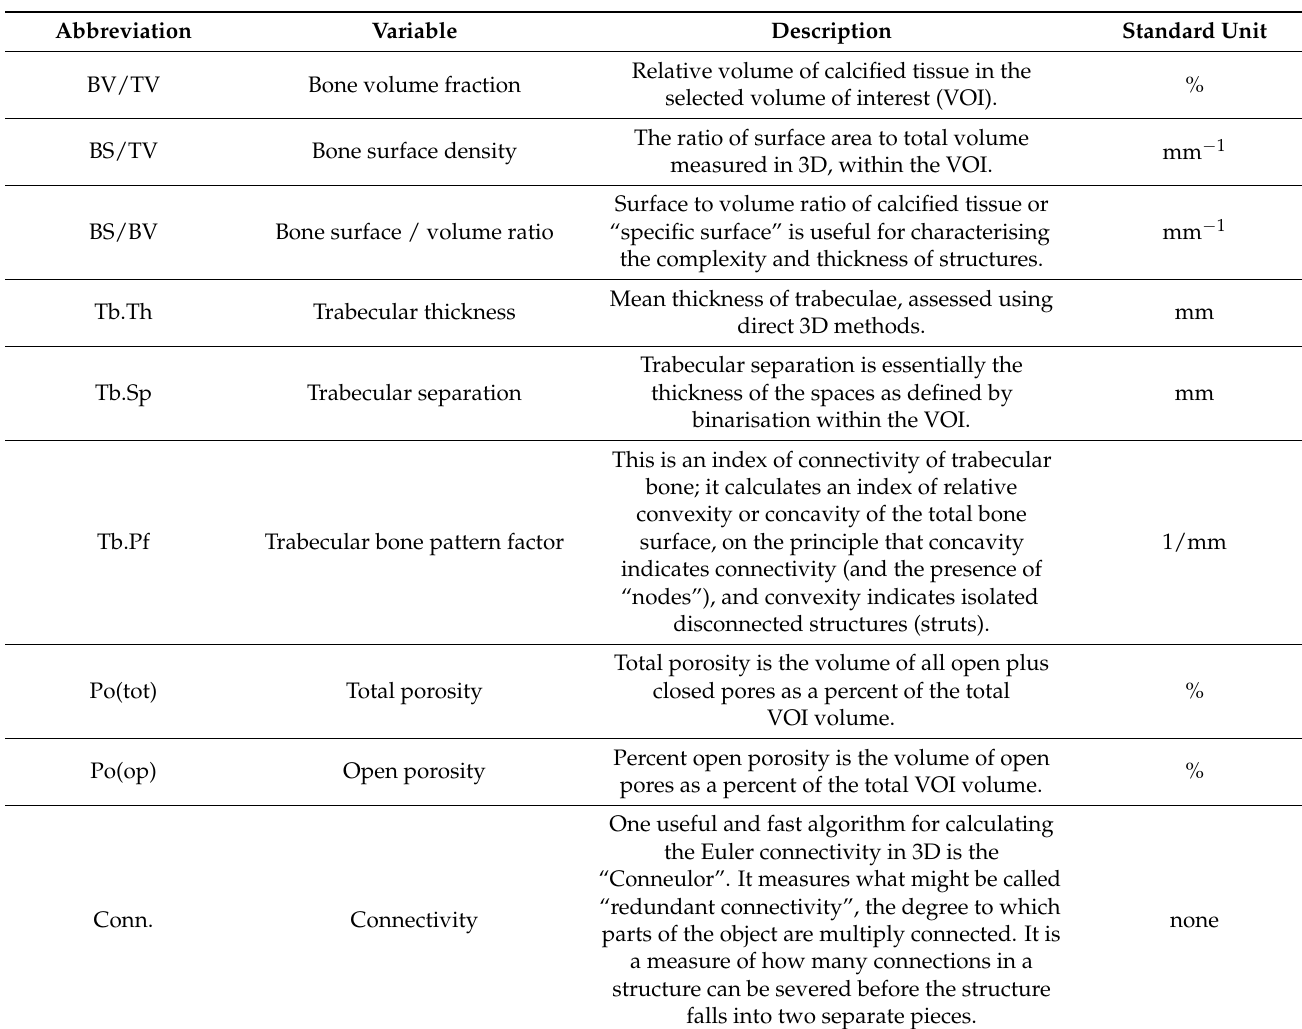
Table 1. The characteristics of morphometric variables investigated in the present study and calculated by CTAn. software (according to the manual Bruker MicroCT Morphometric parameters measured by CT-analyzer software 1.15.4.0 by Bruker